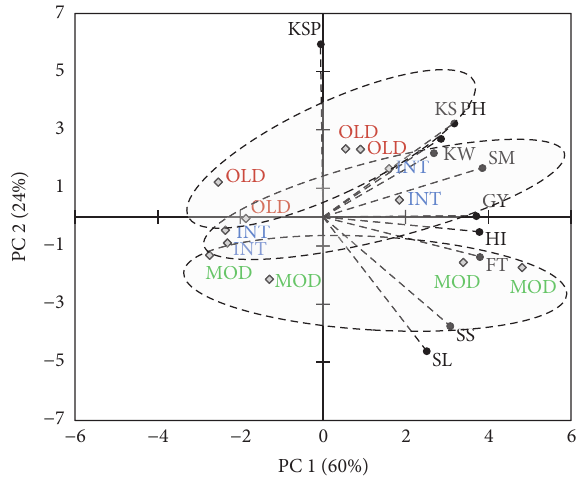
Figure 3: PCA projections on axes 1 and 2 accounting for 84% of total variance. Eigenvalues of the correlation matrix are symbolized as vectors representing traits that most influence each axis. The 12 points representing traits means for each period of release (old (OLD), intermediate (INT), and modern (MOD)) are plotted on the plane determined by axes 1 and 2. Grain yield (GY), spikes per m 2 (SM), kernels per spike (KS), kernel weight (KW), harvest index (HI), spikelets per spike (SS), kernels per spikelet (KSP), fertile tillering (FT), plant height (PH), and spike length